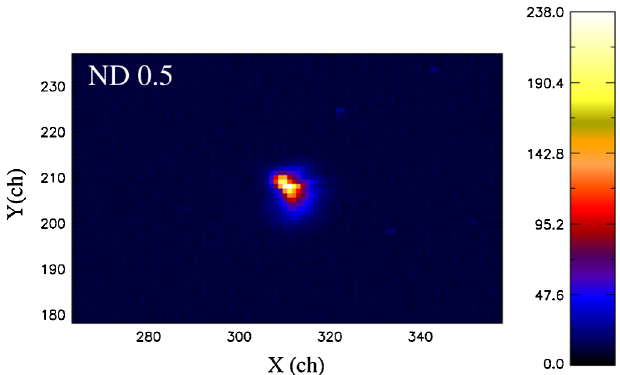
FIG. 9. (Color) An example of VLD0 OTR/COTR data with the 300-A beam and 450-pC micropulse with ND 0.5. The enhanced peaks are about 440 (cid:1) m